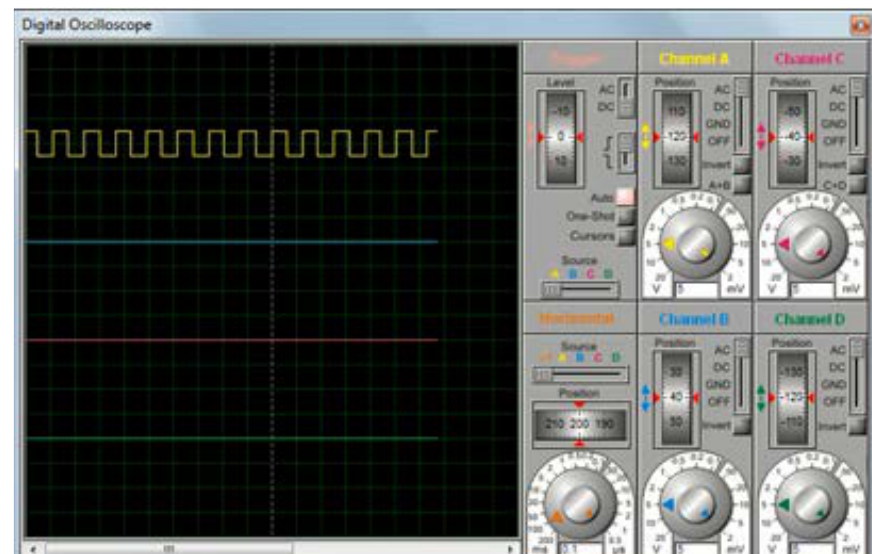
Figure 4. Output signal on the oscilloscope when the potentiometer has its maximum positive